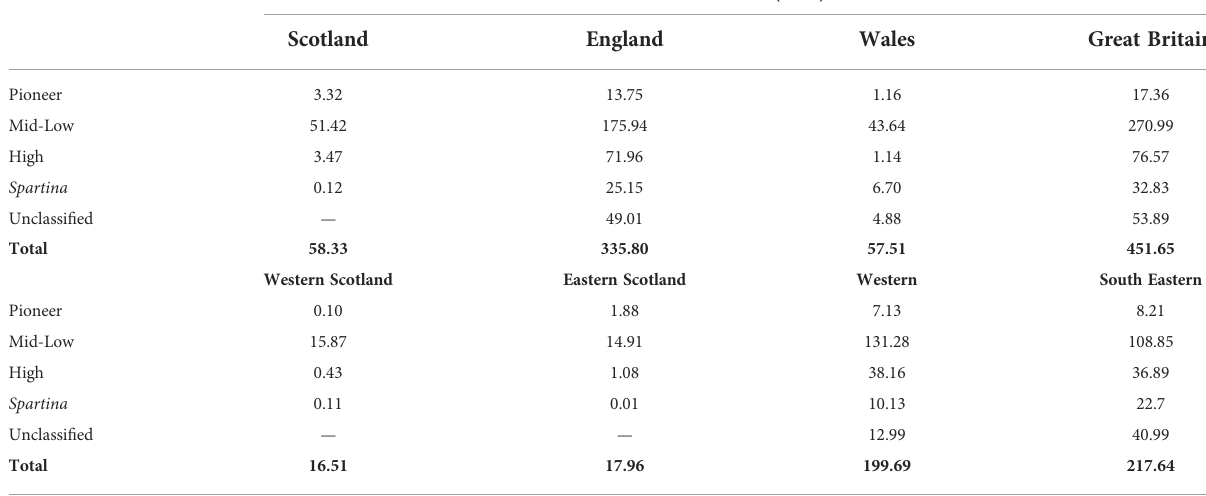
TABLE 1 Areal extent (km 2 ) of saltmarsh habitat across the nations of Great Britain, and the four geo-regions ( Adam, 1978 ; Figure 1